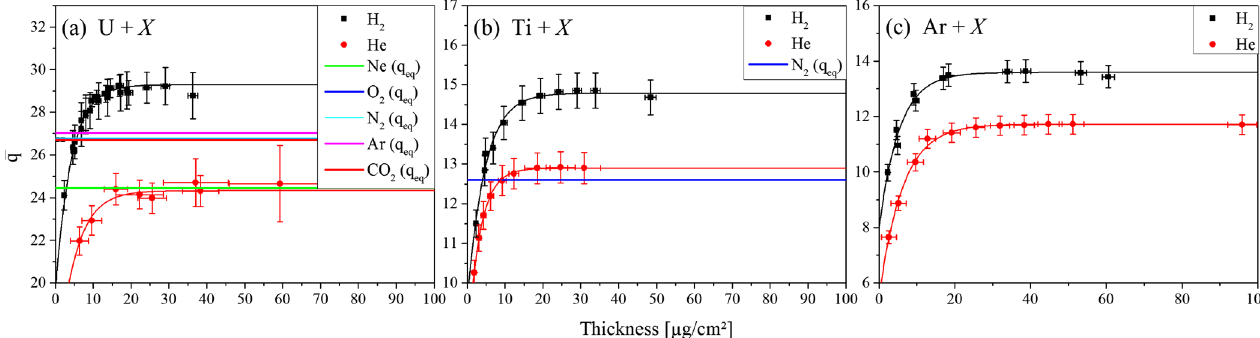
FIG. 11. Mean charge states ¯ q for 238 U (a), 50 Ti (b), and 40 Ar (c) ion beams at 1 . 4 MeV = u. Exponential fits are added to the data points to guide the eye. Saturated mean charge states, measured for ion-gas combinations without thickness estimation, are added as solid lines.